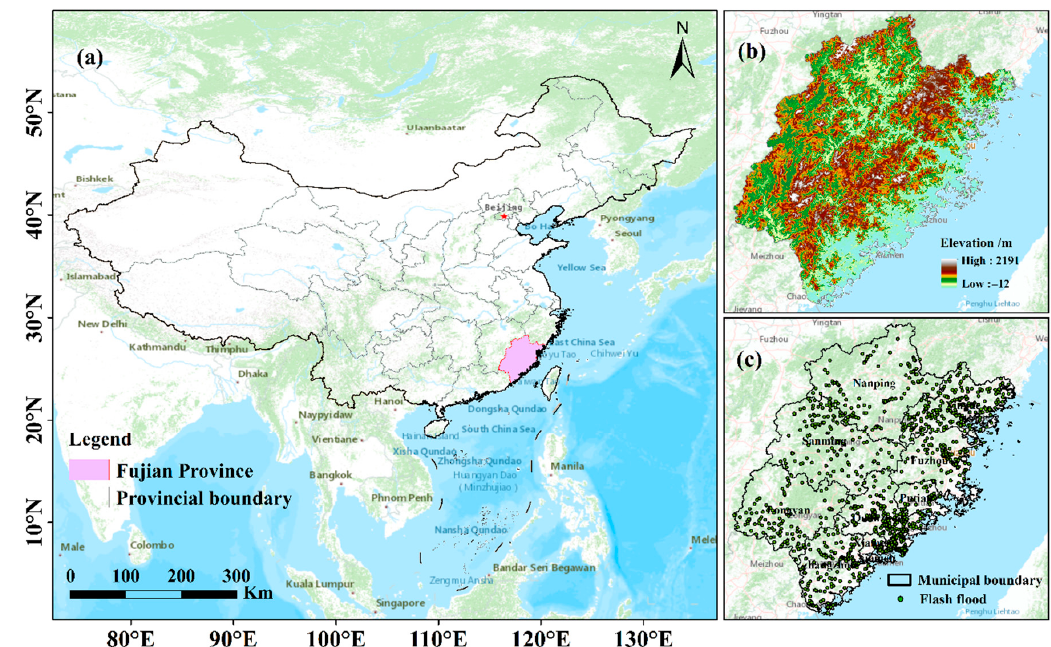
Figure 1. The study area: ( a ) the geographical position of Fujian Province in China, ( b ) the elevation of Fujian Province, and ( c ) the distribution of flash floods in Fujian Province.